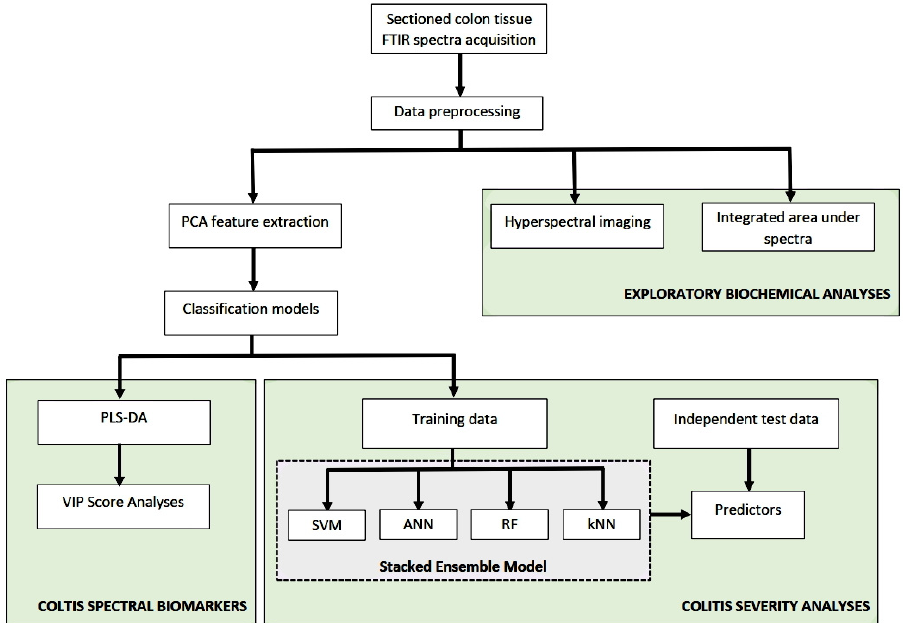
Scheme 1. Spectral data analyses